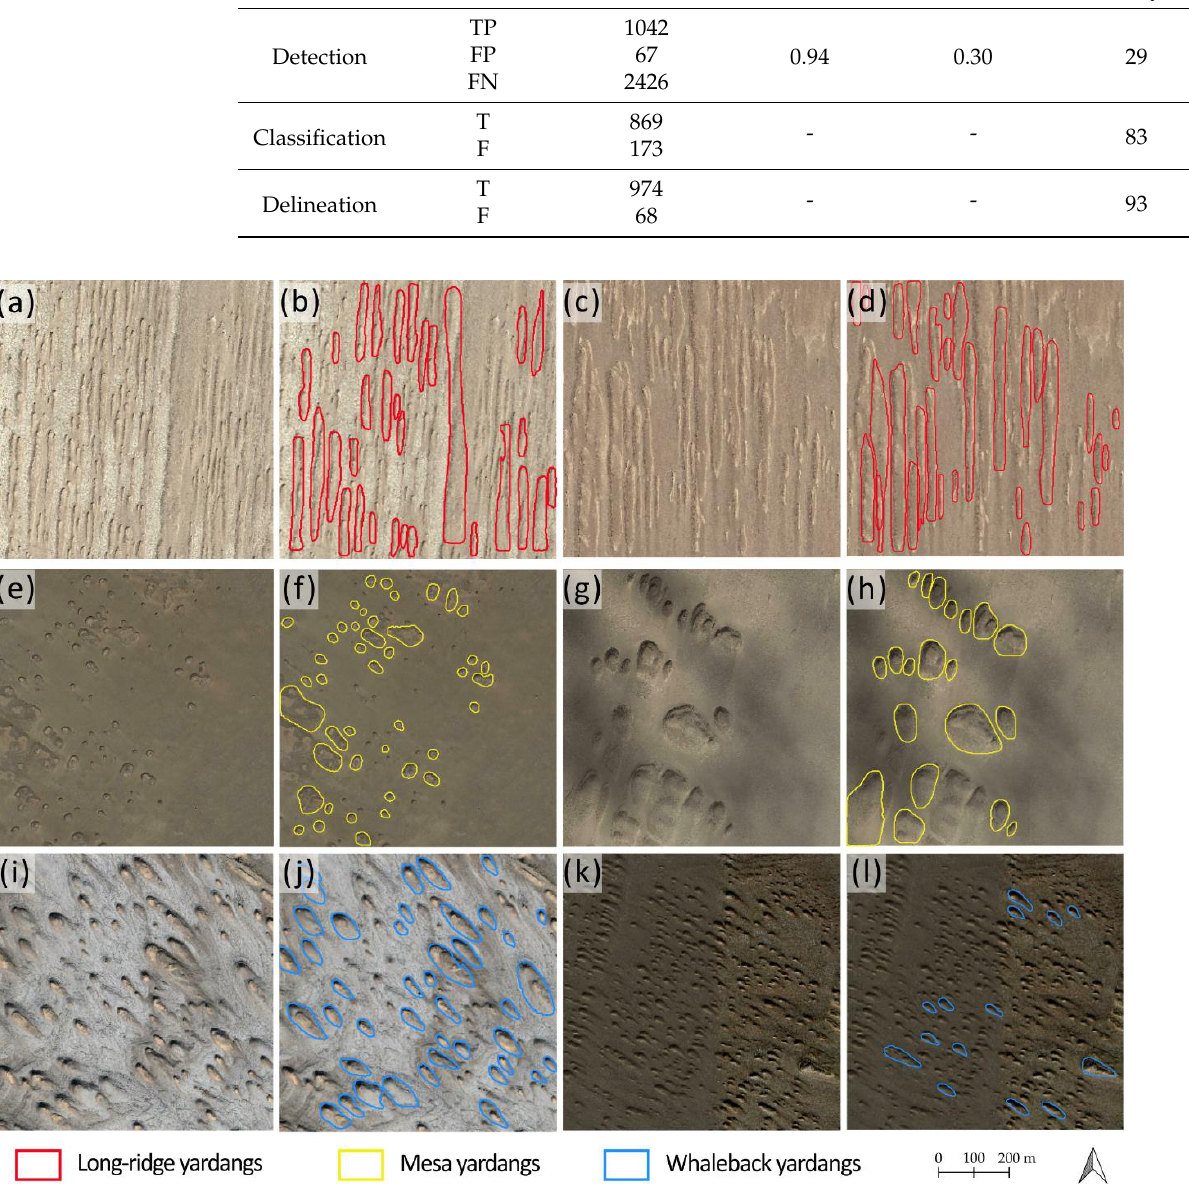
Figure 8. Example delineation and classification results on 3.0 m images. (a,c,e,g,i,k): enlarged 3.0 m spatial resolution images with their locations marked in Figure 2. (b,d,f,h,j,l): corresponding characterization results by Mask R-CNN where long-ridge, mesa and whaleback yardangs are depicted using polygons with red, yellow and blue borders, respectively.